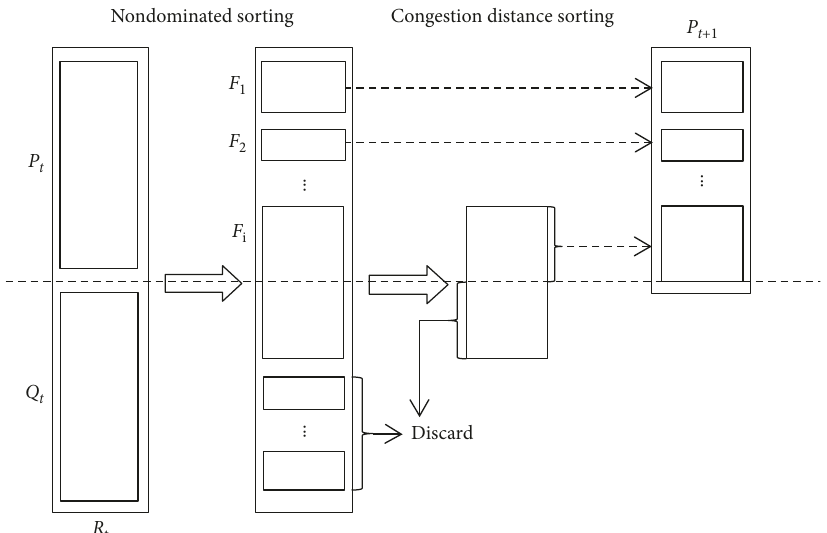
Figure 1: Process sketch of NSGA-II elite